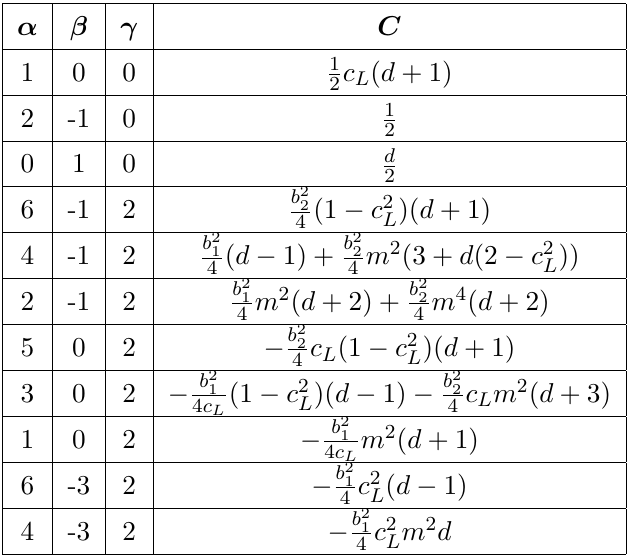
Table 1 . Coefficients C A for all the values of the powers α A , β A , γ A that appear in